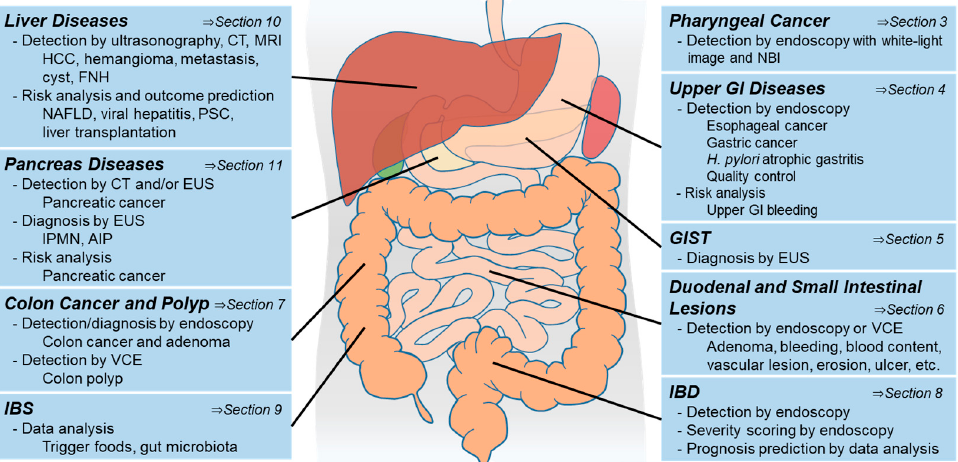
Figure 1. Summary of AI technologies for gastroenterology, hepatology, and pancreatology. IBS: irritable bowel disease, GI: gastrointestinal, GIST: gastrointestinal stromal tumor, IBD: inflammatory bowel disease, EUS: endoscopic ultrasonography, VCE: video capsule endoscopy, NBI: narrow-band imaging, CT: computed tomography, MRI: magnetic resonance imaging, HCC: hepatocellular carcinoma, FNH: focal nodular hyperplasia, IPMN: intraductal papillary mucinous neoplasm, NAFLD: nonalcoholic fatty liver disease, PSC: primary sclerosing cholangitis, AIP: autoimmune pancreatitis.